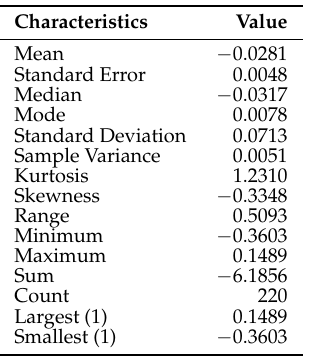
Table 8. Statistical characteristics of the vibration signal of